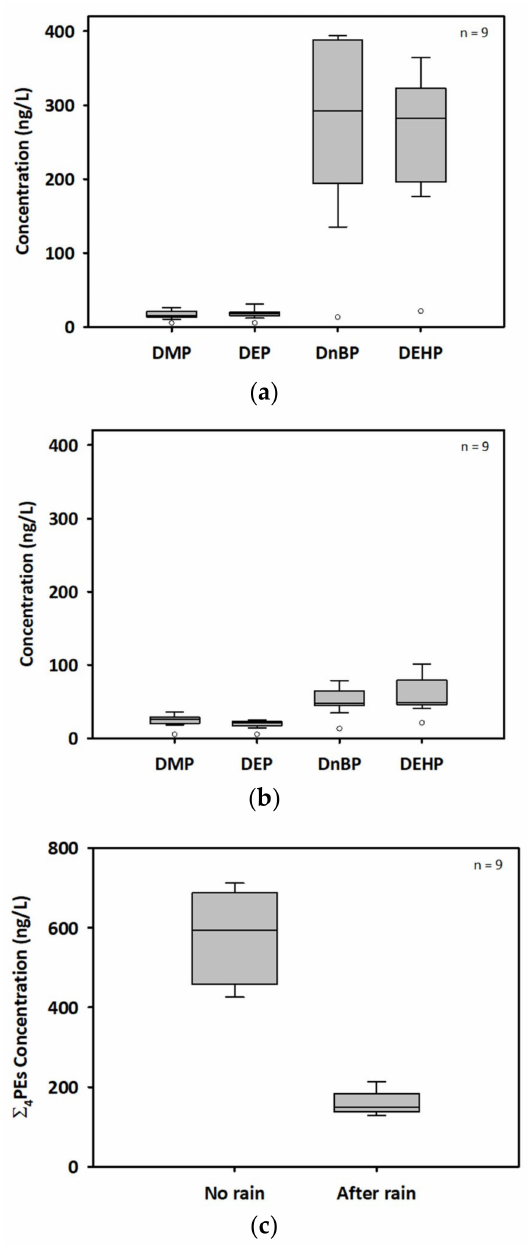
Figure 4. Phthalate ester (PE) concentrations at Ilsan Beach in Spring of 2018: ( a ) before (cid:80) rain, ( b ) after rain, and ( c ) 4 PEs in seawater. n—number of analyzed samples. LOD of each PE. DMP—dimethyl-phthalate; DEP—diethyl-phthalate; DnBP—di- n -butyl-phthalate; (cid:80) DEHP—bis(2-ethylhexyl)-phthalate; 4 PEs—sum of the four PE concentrations. The error bars indicate the standard